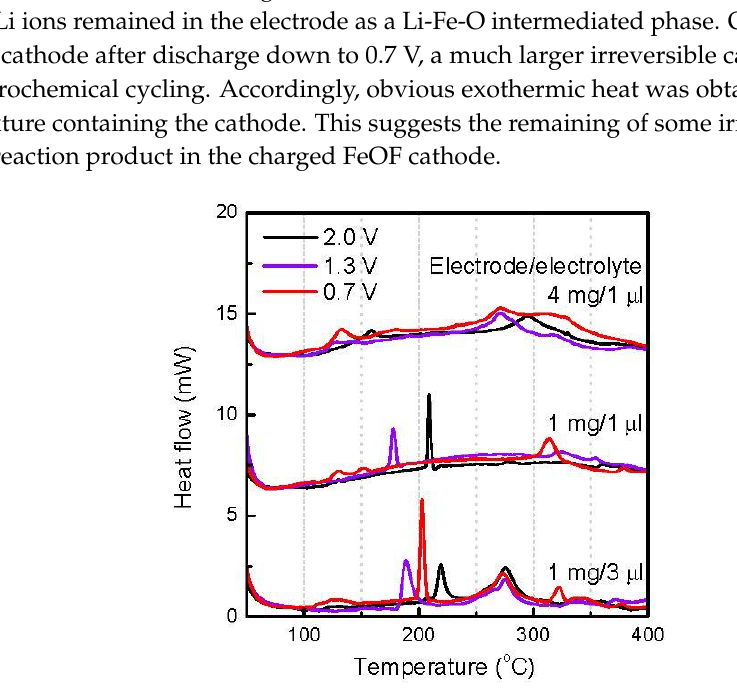
Figure 7. DSC curves of FeOF cathodes charged up to 4.0 V after discharge down to 2.0, 1.3, and 0.7 V with electrolytes in various cathode/electrolyte ratios.